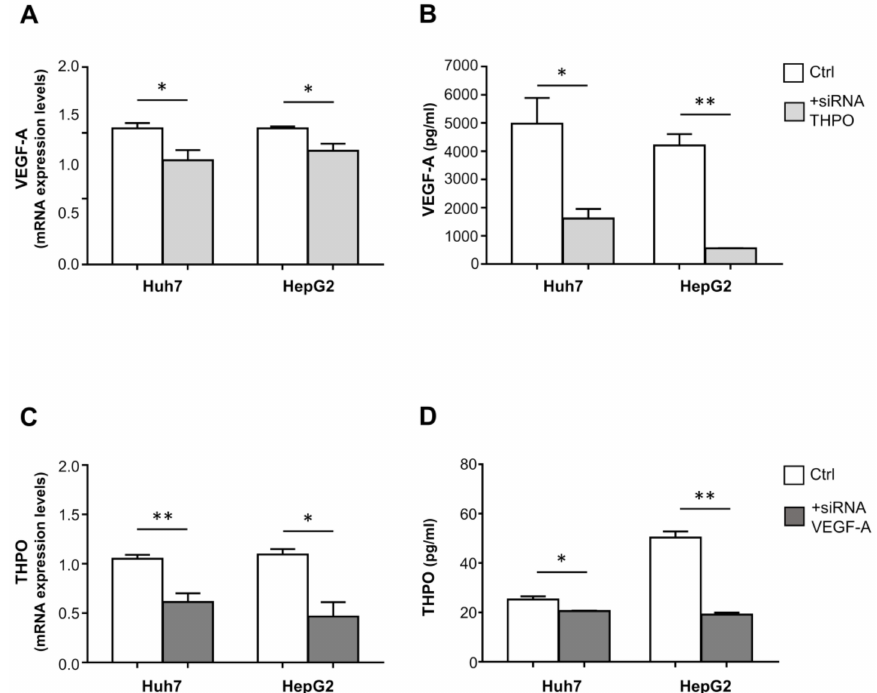
Figure 9. THPO and VEGF-A silencing cross-effects on VEGF-A and THPO transcripts and proteins in hypoxic Huh7 and HepG2 liver cancer cells. mRNA expression and protein levels of VEGF-A and THPO analyzed after transfection with THPO ( A , B ) and VEGF-A ( C , D ) siRNA, respectively. Results are expressed as mean ± SEM of 4 separate experiments. Gene expression values or protein levels are shown as column bars. The p values were obtained by paired t test (* p < 0.05, ** p <